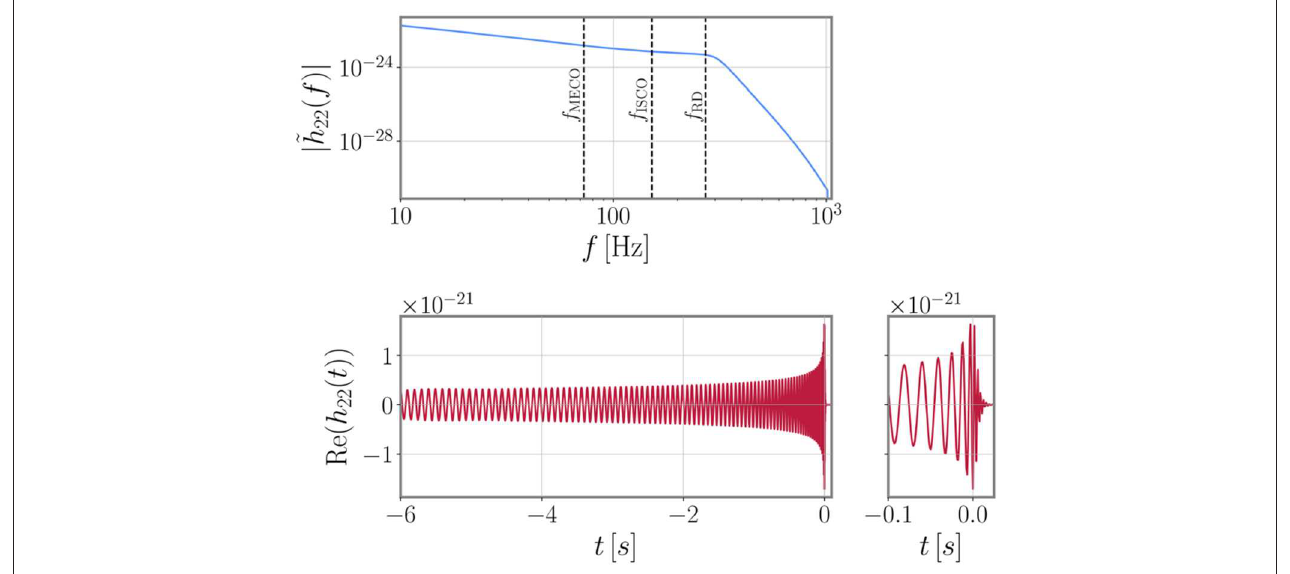
FIGURE 1 | The gravitational waveform of a non-spinning 30 + 30 M ⊙ binary black hole at a distance of 400 Mpc generated from the phenomenological waveform model IMRPhenomX ( Pratten et al., 2020b). The top panel shows the frequency-domain GW strain starting at 10 Hz when viewed face-on. The vertical dashed lines indicate three characteristic frequencies: the frequency of the innermost stable circular orbit ( f ISCO ), the minimal energy circular orbit ( f MECO ) and the ringdown frequency ( f RD ). The bottom panel shows the corresponding time-domain GW, where the smaller right panel shows a close-up of the last few inspiral cycles, the merger, and ringdown